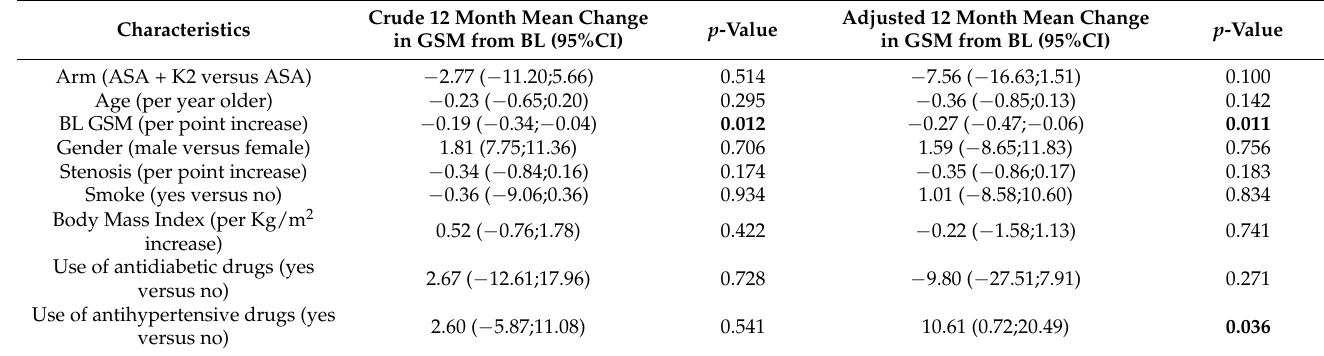
Table 5. Univariable and multivariable linear regression models performed to assess baseline factors associated with 12 months mean GSM change from baseline (BL). Statistically significant p -value (<0.05) are